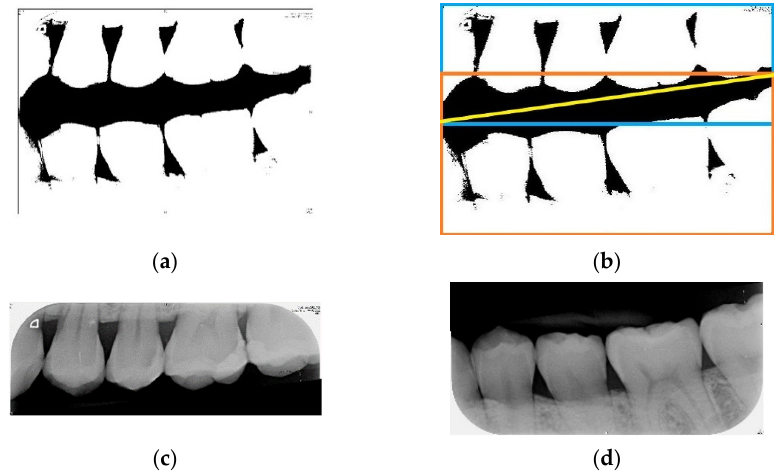
Figure 3. ( a ) The binarized bitewing film; ( b ) the schematic diagram of slicing the bitewing film, where the yellow line is the separating line, the blue bounding box is the area of the photo of the upper row of teeth in the bitewing film, and the orange bounding box is the area of the photo of the lower row of teeth in the bitewing film; ( c , d ) photos of the upper and lower rows of teeth after slicing,